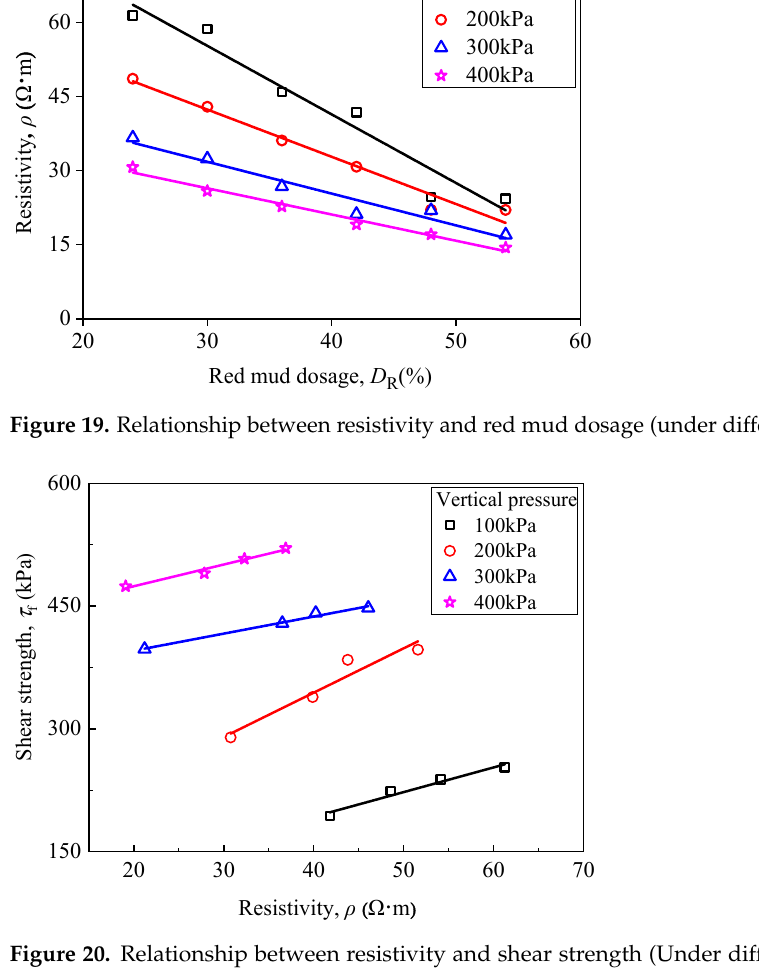
Figure 20. Relationship between resistivity and shear strength (Under different vertical pressure, D R = 42%).